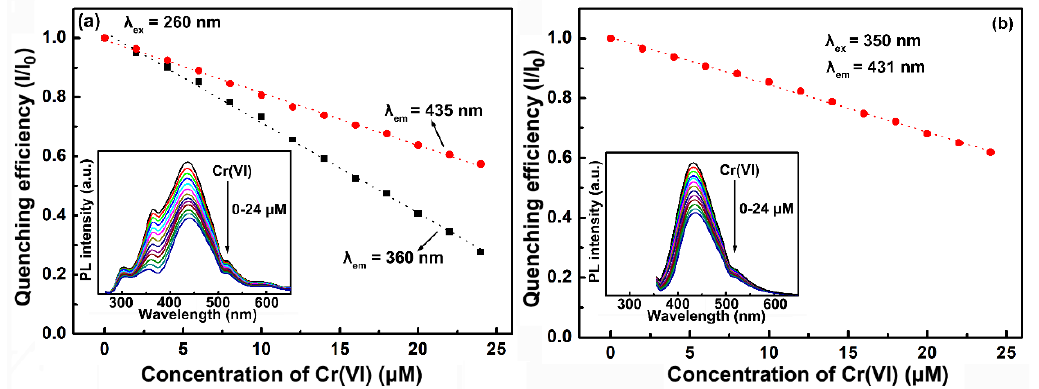
Figure 8. ( a ) Quenching efficiency (I/I0) of the 360 nm (black curve) and 435 nm (red curve) peaks as a function of Cr(VI) concentration. The excitation wavelength was 260 nm. ( b ) Quenching efficiency of the 431 nm peak as a function of Cr(VI) concentration. The excitation wavelength was 350 nm.